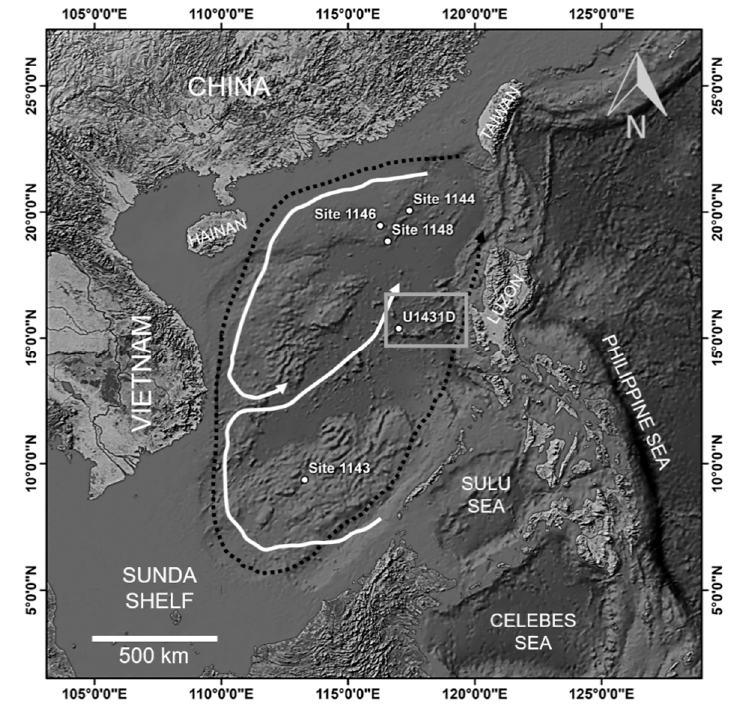
Figure 1. Site U1431 (15°22.5371 ′ N, 117°00.0022 ′ E) enclosed by the box is the core used in this study. Other dots correspond to drill sites from Ocean Drilling Program (ODP) Expedition 184. The black dotted line represents the winter surface circulation of the South China Sea (SCS). The white solid line indicates summer surface circulation (modified from [46]).